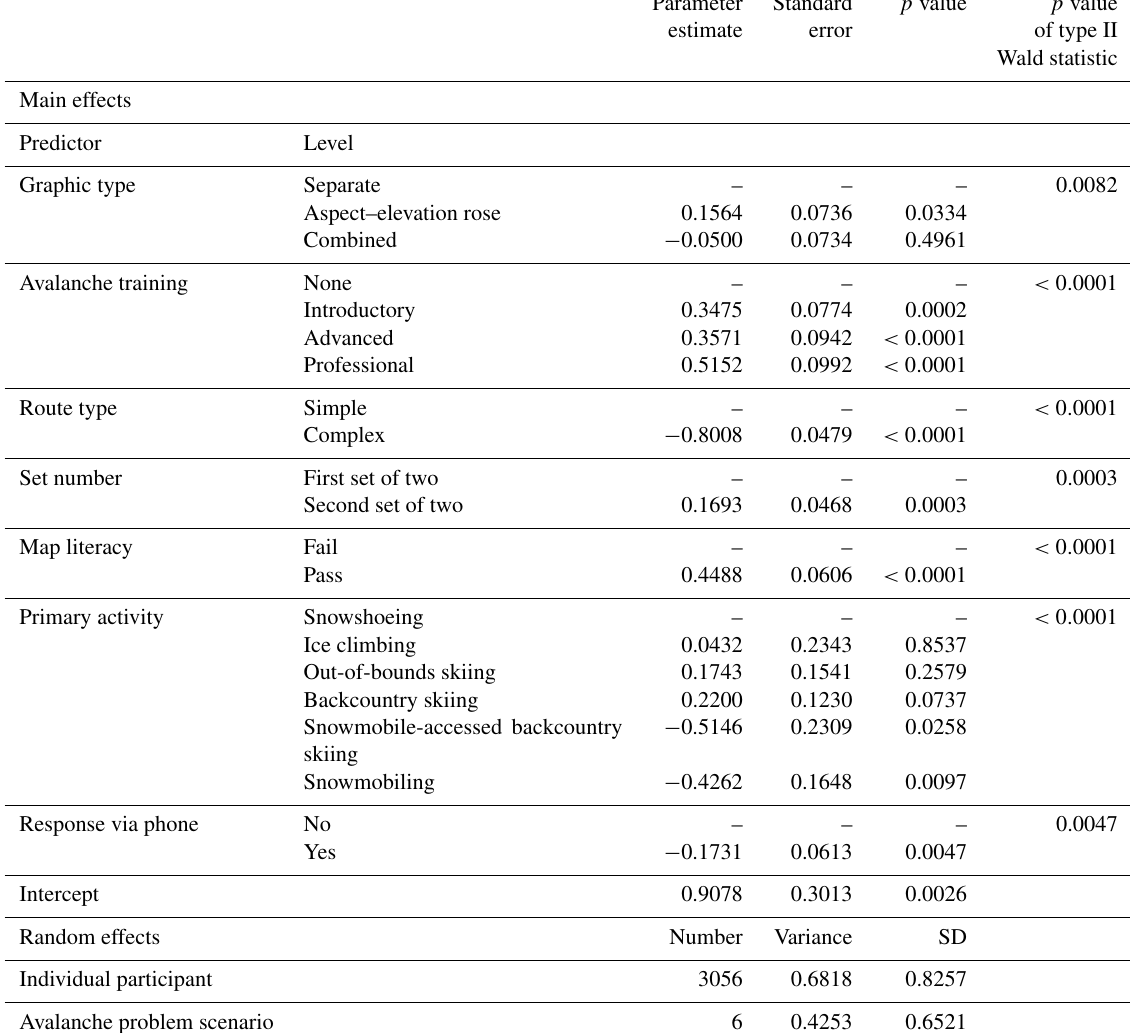
Table 1. Parameter estimates of regression model examining the correctness of participants’ responses in the route ranking exercise. Dashes (–) indicate that the level represents the base level of the attribute, and SD stands for standard deviation. The number of observations =